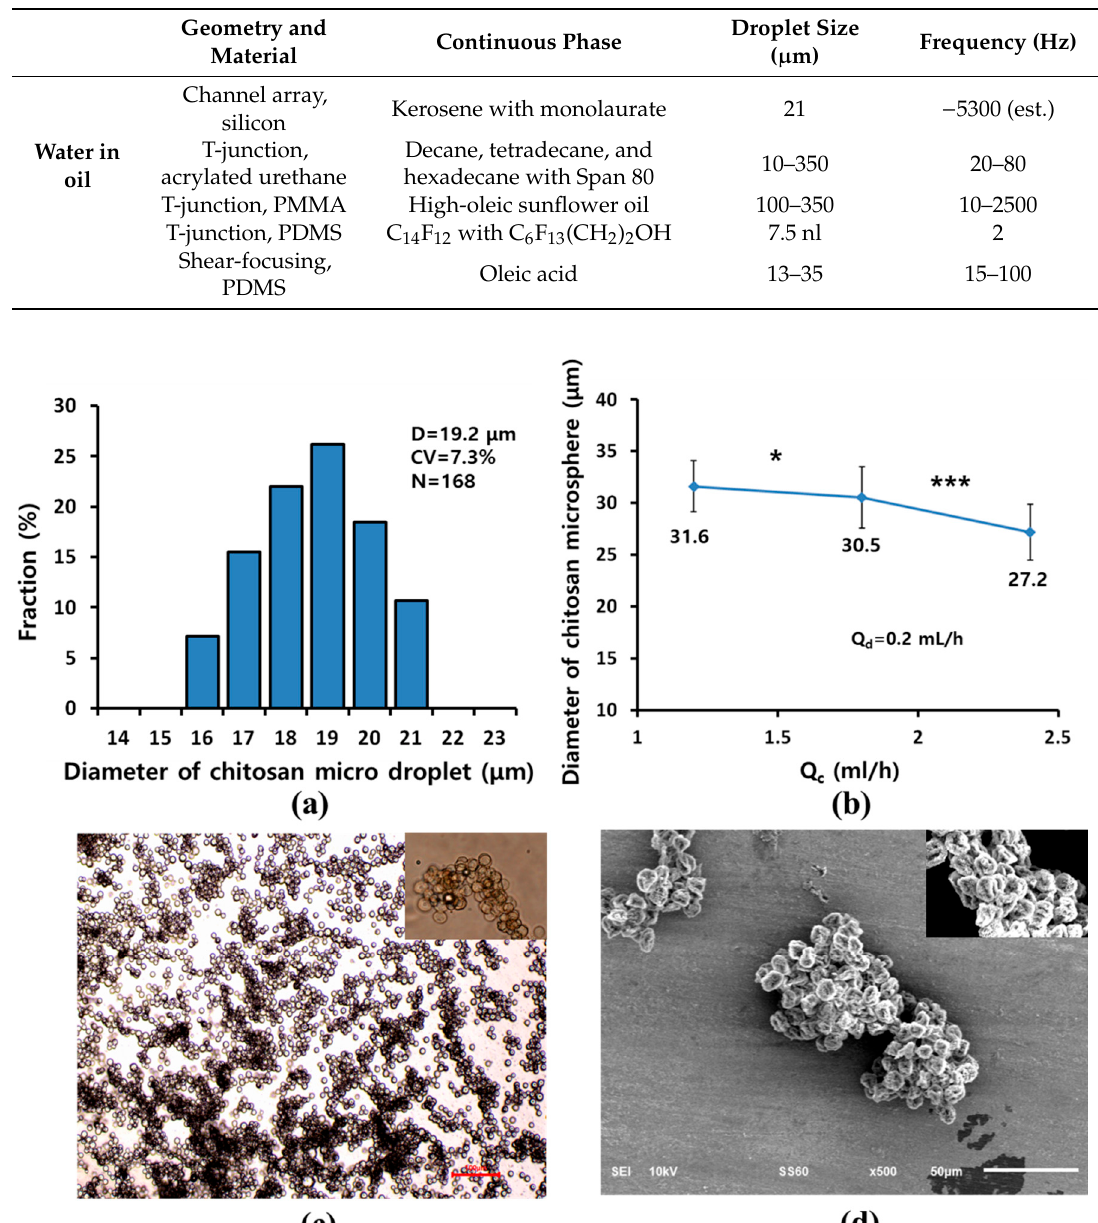
Size and frequency of water droplets in oil in various microfluidic systems.